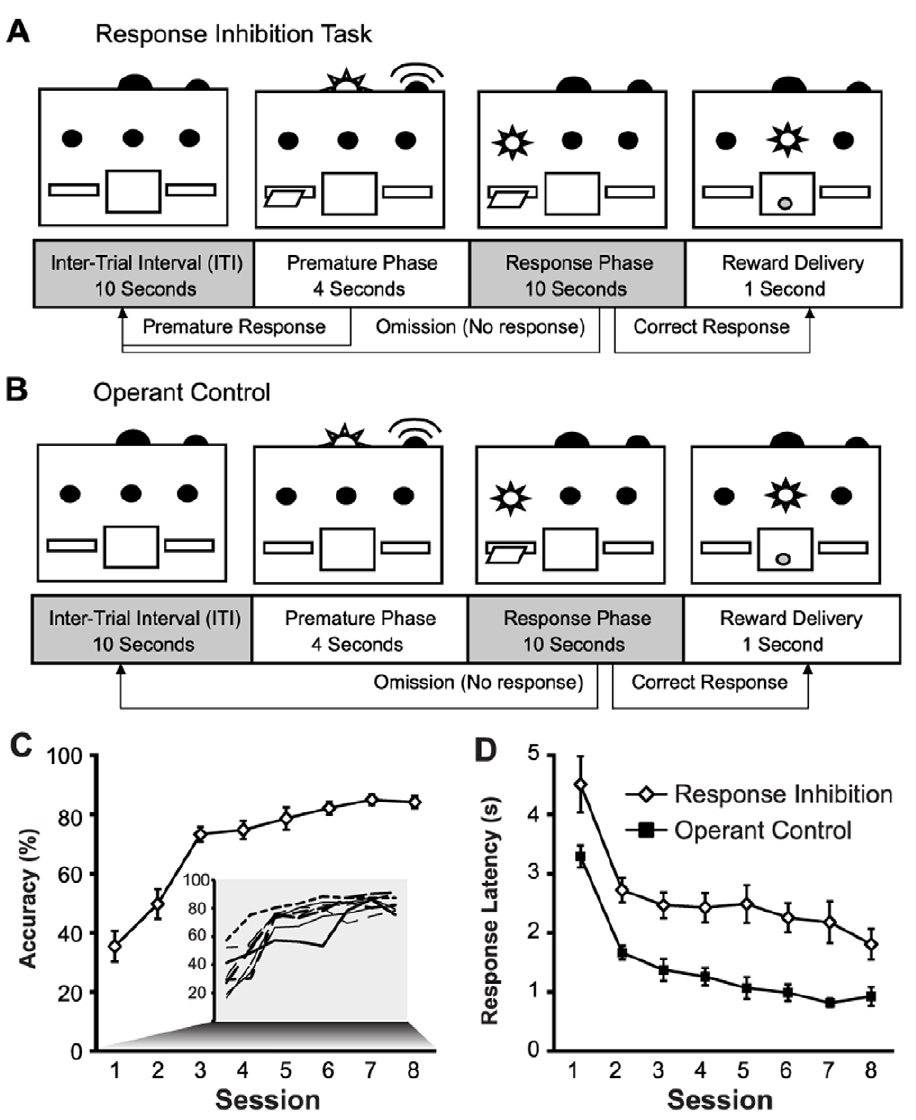
Figure 1. Behavioural training. A. The response inhibition (RI) task requires subjects to withhold responding until the correct phase. Responses during the correct phase result in a sucrose pellet reward and reinstate the intertrial interval (ITI). Responses during the premature phase restore the ITI with no reward. Failure to respond during the correct phase results in an omission and reinstates the ITI. B. The Operant Control condition is identical to the RI task, but the lever is withdrawn during the premature phase, preventing any premature responses. C. Accuracy rapidly improves over 8 sessions of training on the RI task (n=8). D. Latency to respond decreases over training sessions on the RI (n=8) and Operant control (n=5) tasks. Response latencies were reduced in Operant Control subjects across all